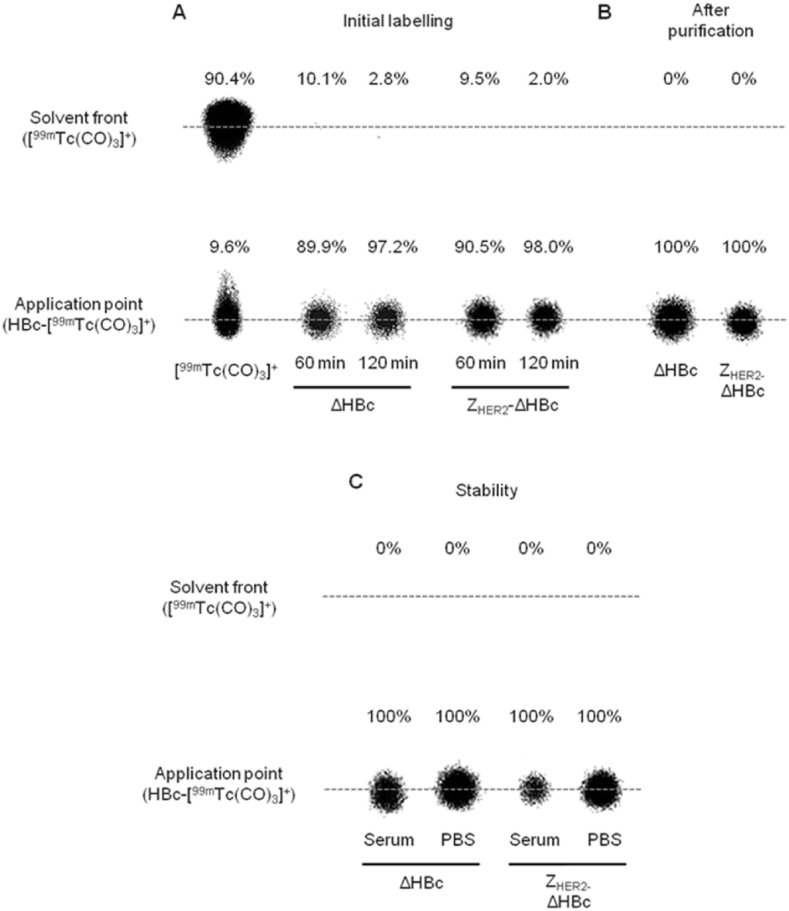
Radiolabelling efficiency, purification and in vitro serum stability of recombinant HBc particles by phosphor imaging. (A) The radiolabelling reaction was carried out at 37 °C and monitored for 2 h with labelling efficiency determined at 60 and 120 min. 97.2% and 98.0% radiolabelling efficiency was achieved for ΔHBc and ZHER2-ΔHBc, respectively. (B)99mTc-ΔHBc and 99mTc-ZHER2-ΔHBc was purified from free [99mTc(CO)3]+ and buffer exchanged with PBS buffer using 10 kDa MWCO Vivaspin. Both types of HBc particles exhibited 100% radiolabelling efficiency. (C) Serum stability was tested by incubation of 99mTc-ΔHBc and 99mTc-ZHER2-ΔHBc in 50% serum or PBS buffer at 37 °C up to 24 h. Both types of HBc particles exhibited 100% stability in serum and PBS indicated by no [99mTc(CO)3]+ at the solvent front.